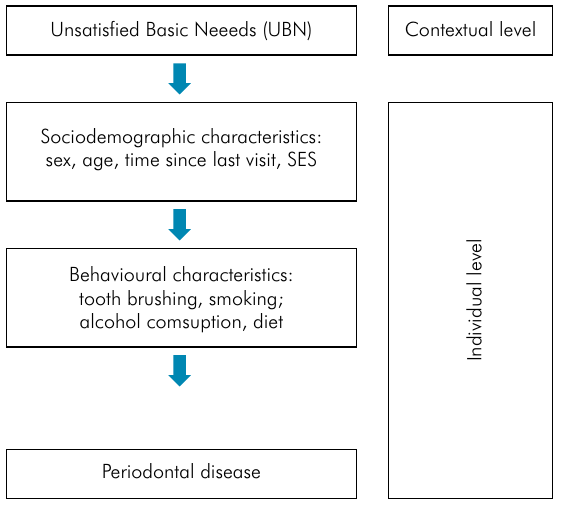
Figure. Hierarchical model of the relationship between contextual and individual explanatory variables of periodontal